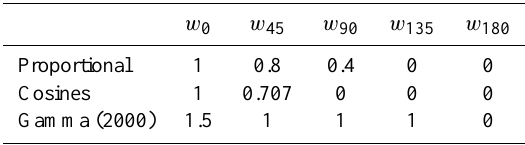
Table 1. Implemented weightings of the persistence function in the assessment of the